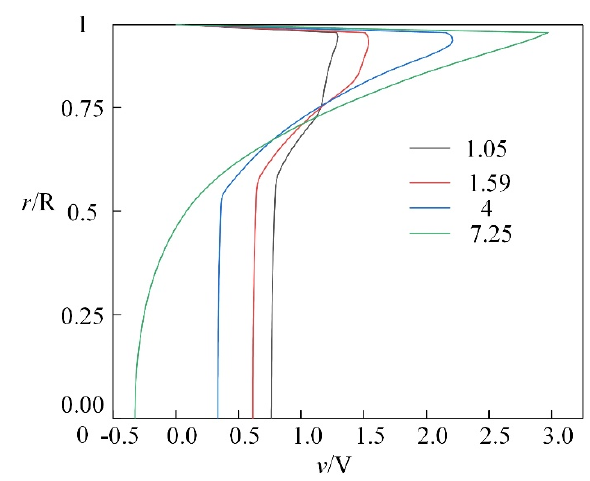
Figure 10. The axial velocity profile of the throat inlet.